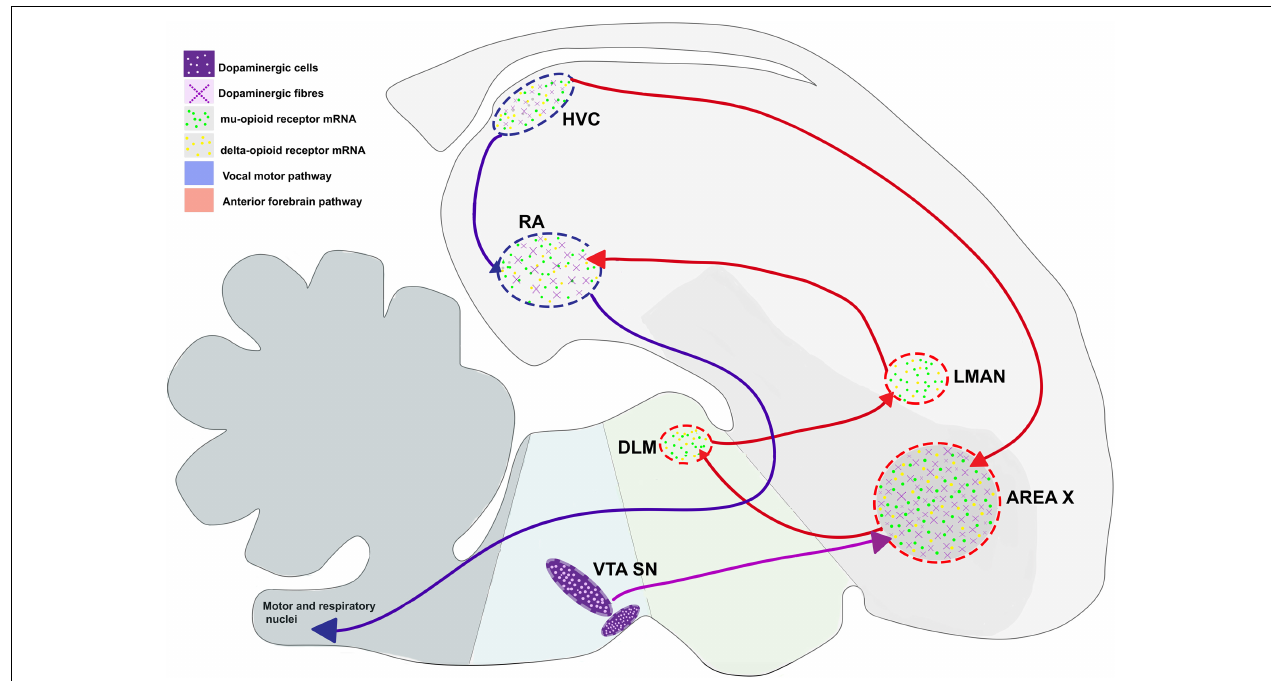
FIGURE 2 | Expression pattern of µ - and δ -opioid receptors and the dopaminergic system in the vocal control nuclei in the songbird brain, based on data from Bottjer (1993) and Khurshid et al. (2009). Blue arrows represent connections of HVC connections, red arrows represent connections of AFP, and violet arrows represent dopaminergic input. DLM, dorsolateral nucleus of the medial thalamus; LMAN, lateral magnocellular nucleus of the anterior nidopallium; RA, robust nucleus of the arcopallium; SN, substantia nigra; VTA, ventral tegmental area.